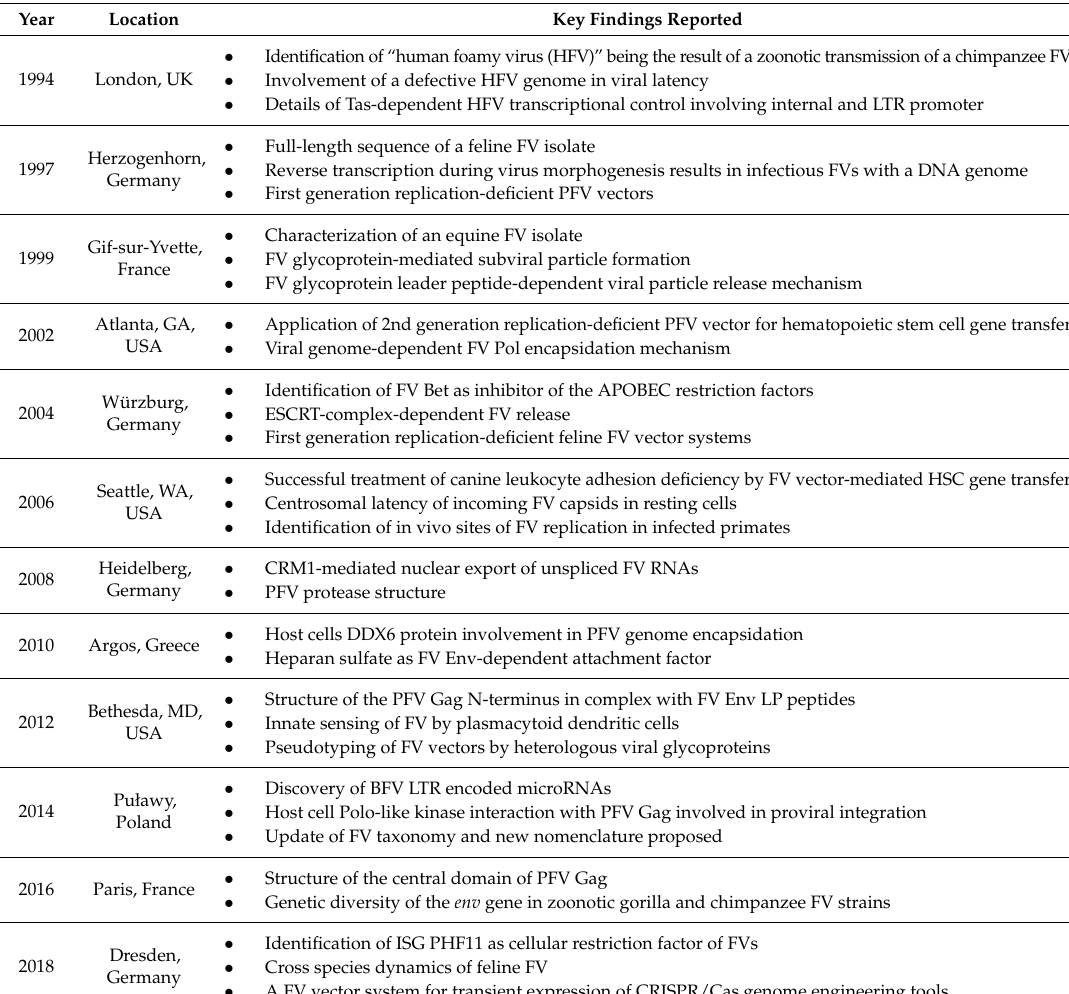
Table 1. Foamy virus conference